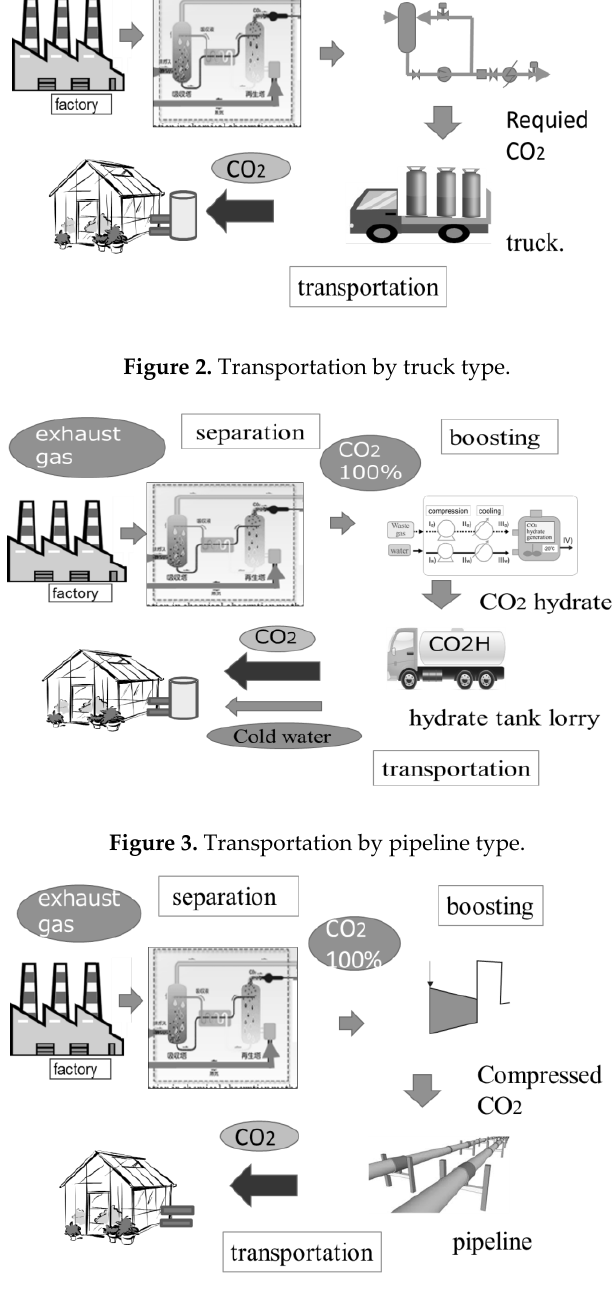
Figure 4. Transportation by pipeline